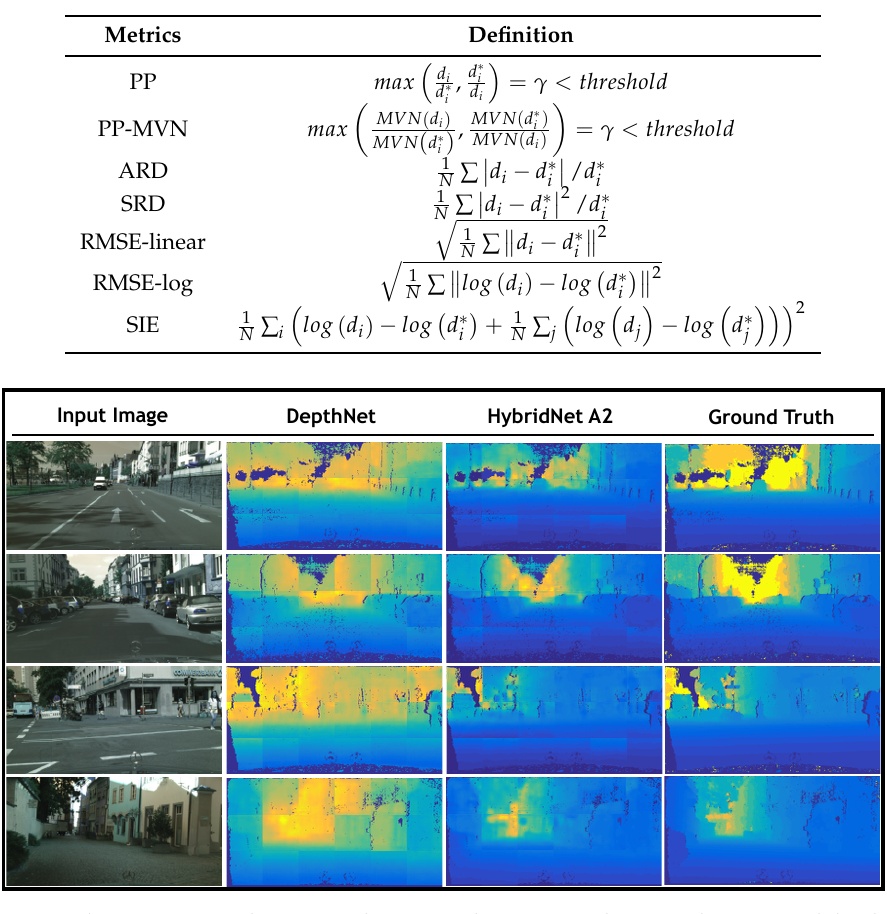
Figure 6. Depth estimation qualitative results. A visual comparison between the estimated depth maps against the ground truth is presented. In the first column the input image is presented, columns 2 and 3 depict the estimated depth maps obtained by DepthNet in [19] and our hybrid model A2, respectively. Finally, ground truth is presented in column